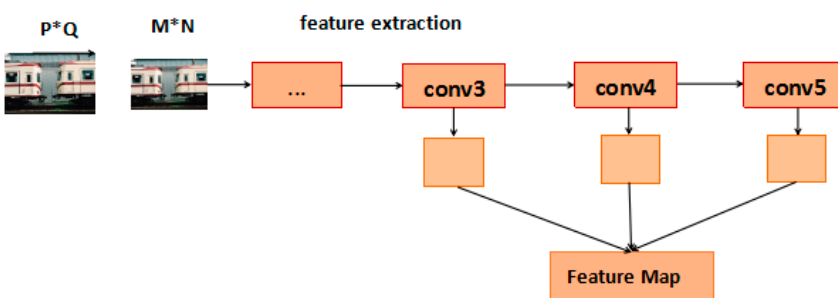
Figure 5. Detailed process of feature fusion. We fused feature maps from the third, fourth, and fifth convolution layers(con_3, con_4, convolution layers(con_3, con_4, con_5).